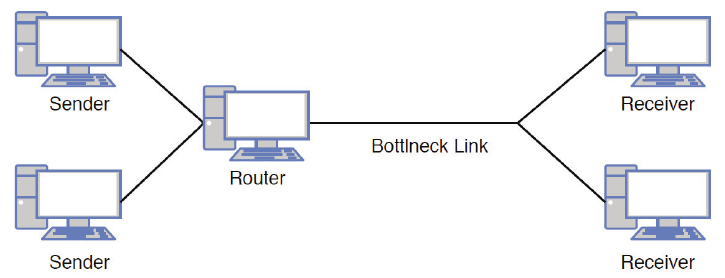
Figure 11. Schematic of the dumbbell topology used in the